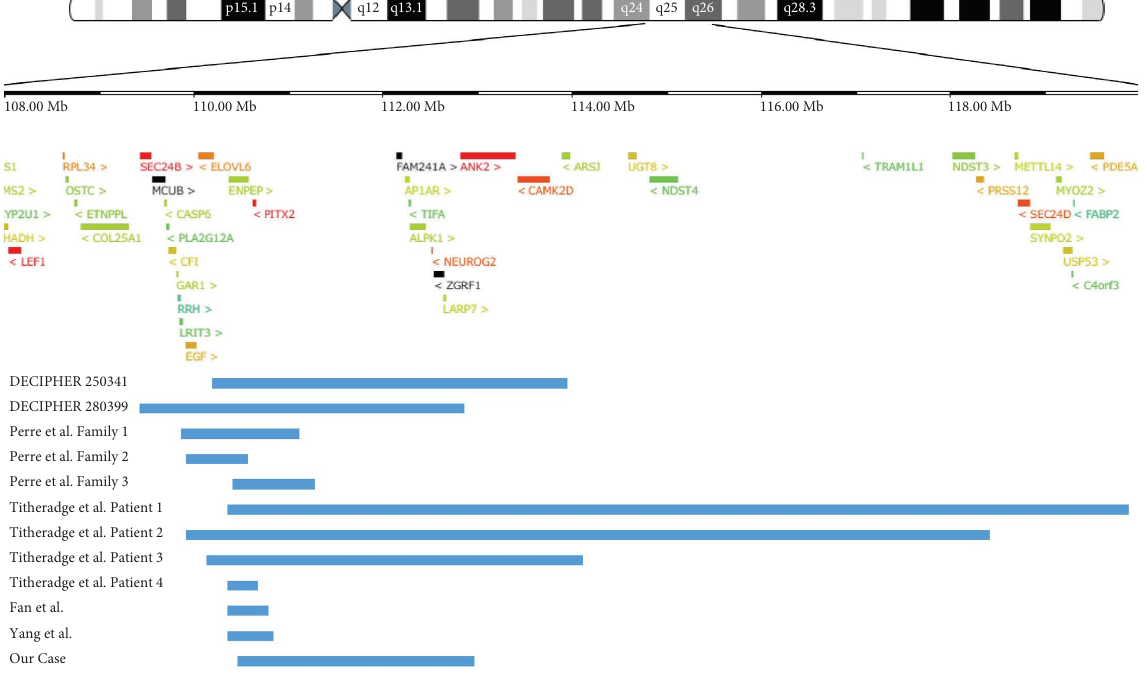
Figure 2: Reported cases with microdeletions of less than 10Mb encompassing PITX2 are shown. Blue lines show the range of deletions. Protein-coding genes colored by pHaplo scores were downloaded from the DECIPHER browser [17] (https://www.deciphergenomics.org/ search/patients/browser?q=4%3A108000000-120000000, accessed on 25 December